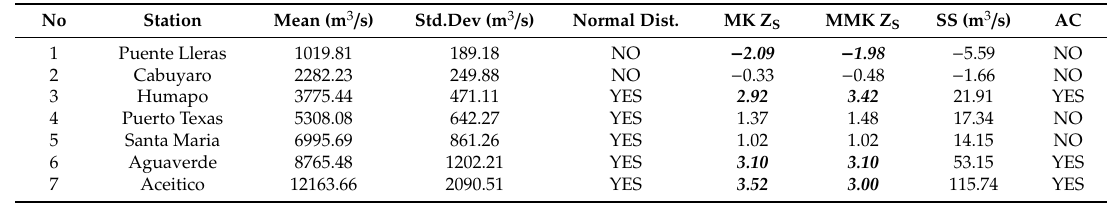
Table 3. Summary of annual maximum streamflow trend test using MK, MMK, and SS in the Meta